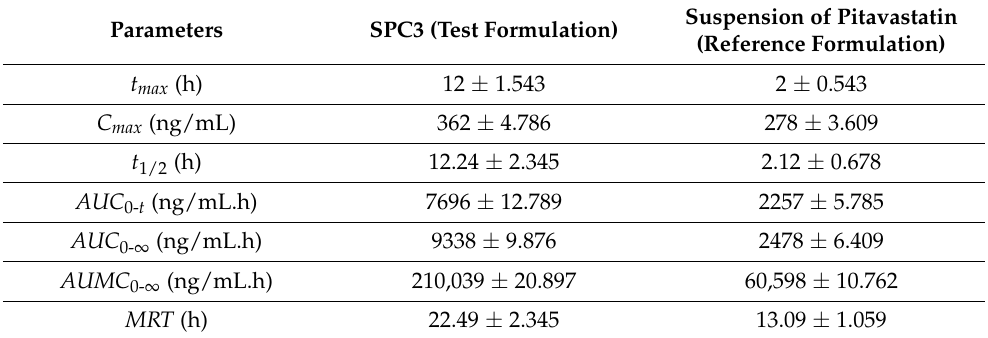
Table 4. Parameters of pharmacokinetics of SPC3 and suspension of